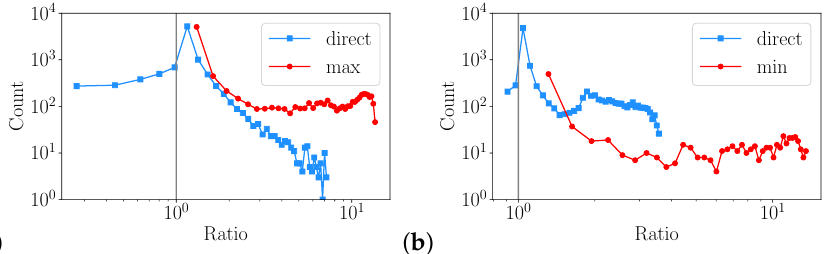
Figure 12. Results of Monte Carlo analysis over single random interval [ T min , T max ] for 10,000 samples. ( a ) isobaric specific heat capacity c p ; ( b ) thermal conductivity k . ‘Direct’ is ratio φ / ¯ φ ; ‘max/min’ are ratios φ ext / ¯ φ . A ratio of 10 0 means that the physical value is exactly